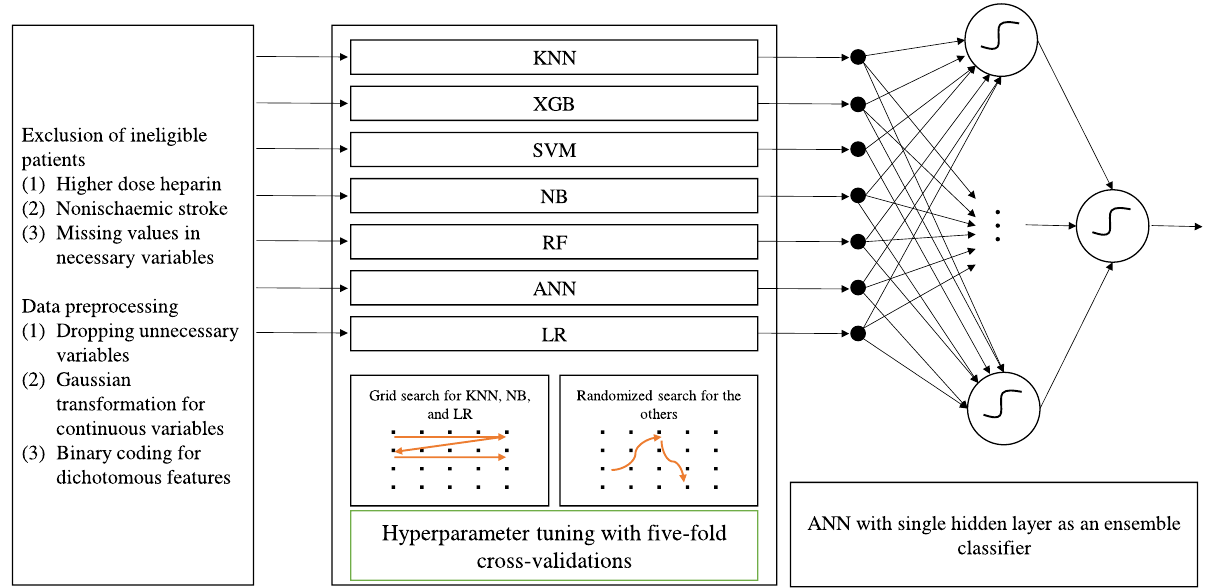
Figure 1. Design of stacking ensemble learner. Seven base classifiers are hyperparameter-tuned individually, and each produces a prediction value. The seven outcome prediction values are input variables for the stacking ensemble learner. KNN: k-nearest neighbours; XGB: extreme gradient boosting; SVM: support vector machine; NB: Naïve Bayes; RF: random forests; ANN: artificial neural networks; LR: logistic